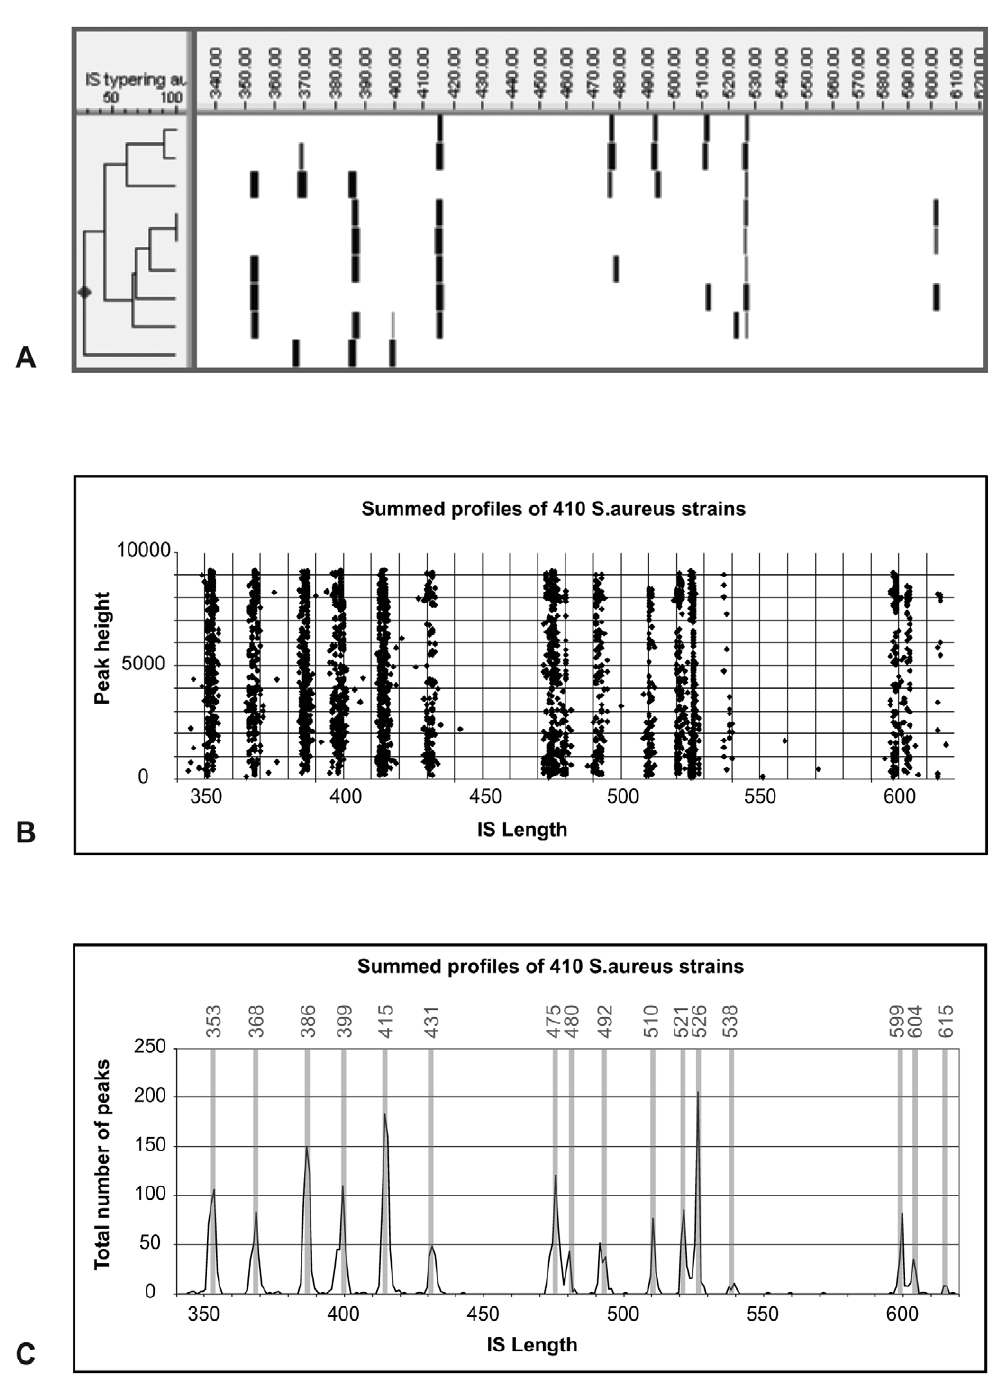
Figure 1. Common IS fragments in S.aureus . A : Representation of IS profiles of 9 strains of S. aureus . In this subset, 11 of 16 common bands are represented. B: Superposition of all 424 S. aureus profiles. Every data point represents a peak ( . 10% of average peak height within a profile). X-axis represents fragment length, Y-axis represents peak height in relative fluorescence units (RFU). The 16 distinct fragment lengths are clearly visible in this representation. C: Total number of peaks for all fragment lengths. The 16 common fragment lengths are marked by the grey lines. Not all fragment lengths are equally common, especially fragments of 538 and 615 nt length are rare. Peaks of which , 10 representatives were found were not included in the set of 16 common peaks. doi:10.1371/journal.pone.0013671.g001 This became especially apparent when all profiles were superim- from background noise. Among the 424 isolates tested, 134 unique patterns were observed. Every pattern was composed of three to posed over one another as shown in figure 1B and C. Each band seven fragments of different length. Over all different patterns, the pattern could thus be assigned a binary code of 16 digits reflecting total number of different fragment lengths that we found was 16. presence or absence of each defined band category. We calculated